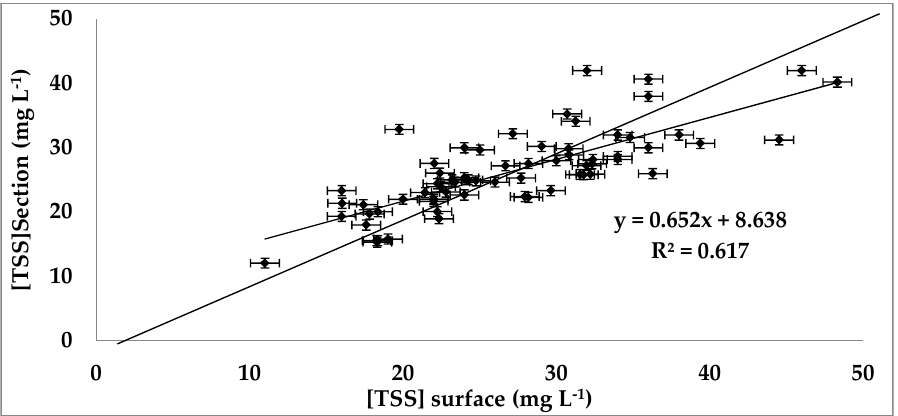
Figure 10. Average vertical TSS concentration versus surface TSS concentration for Congo River at BZV/KIN during SOH program.